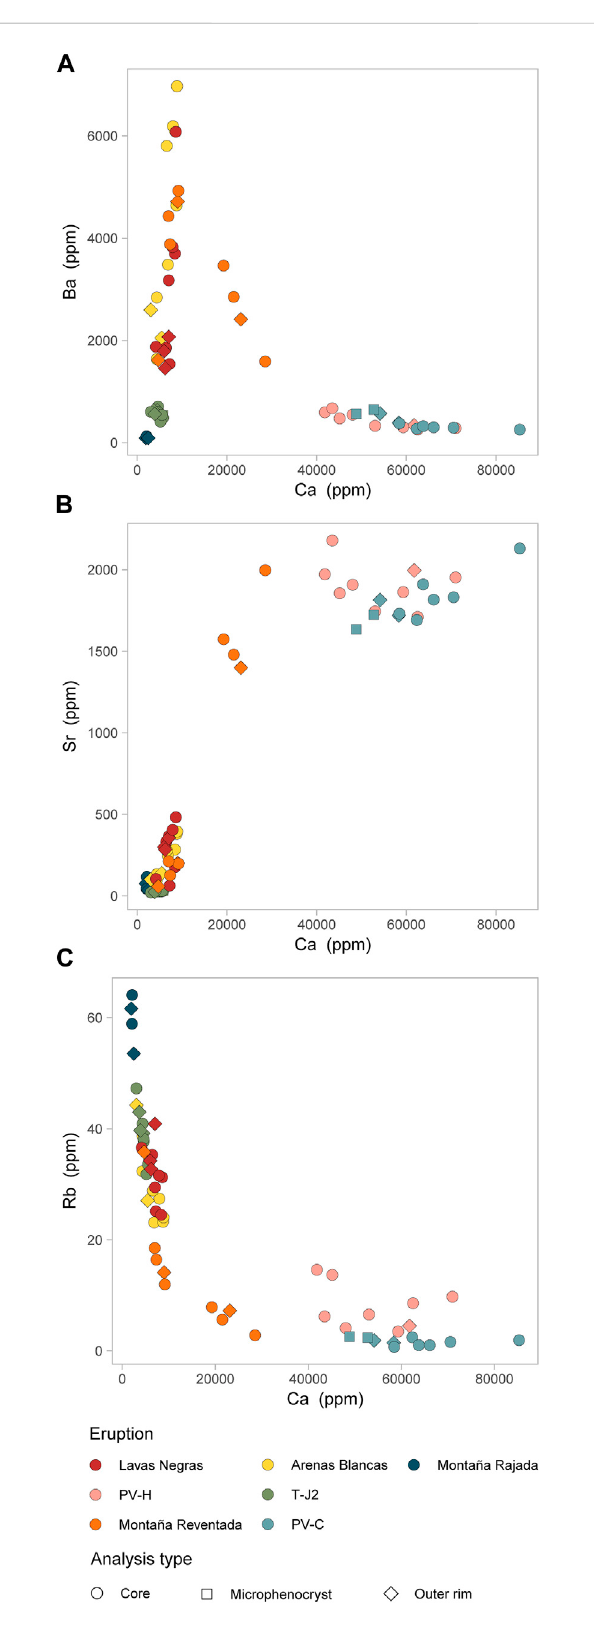
FIGURE 7 Diagrams showing Ba (A) , Sr (B) , Rb (C) covariations with Ca (in ppm) in feldspars obtain by LA-ICP-MS. Symbols as Figure